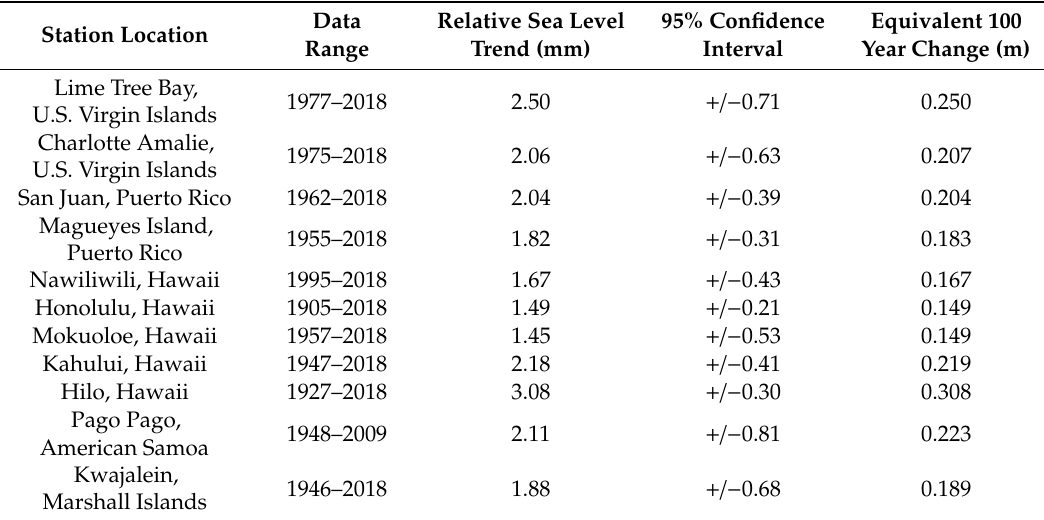
Table 4. Relative sea level trends and equivalent 100 year change reported by the U.S. National Oceanic and Atmospheric Administration based on monthly mean sea level data over the entirety of the available data range measured by tide gauges at long term monitoring sites in the Caribbean and Pacific (listed east to west) [97]. Data Relative Sea Level 95% Confidence Equivalent 100 Station Location Range Trend (mm) Interval Year Change